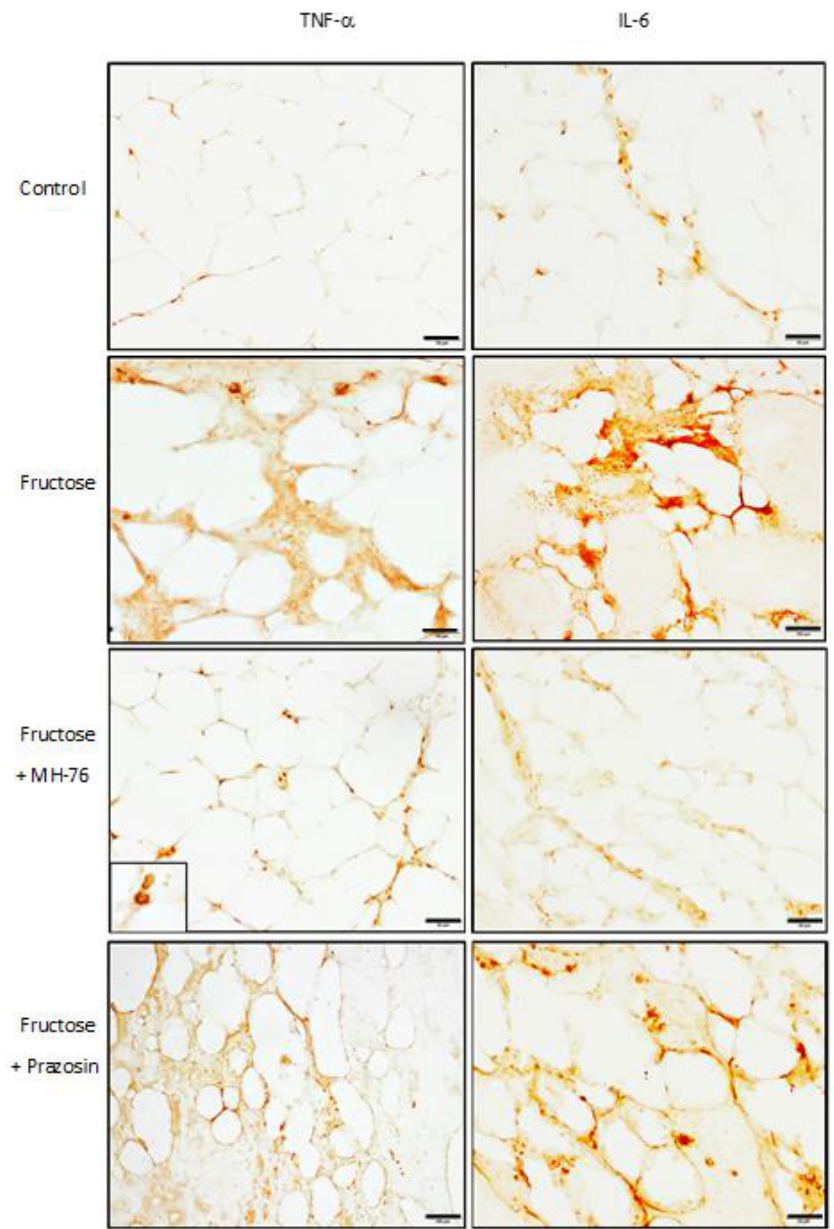
Figure 10. The representative immunohistochemical (IHC) photomicrographs of proinflammatory cytokines—TNF- α and Il-6 expression in the abdominal adipose tissue samples from studied groups. Both IL-6 and TNF- α expression was present in inflammatory cells (in enlarged box), in some endothelial cells and also in adipocytes and were elevated in Fructose and Fructose + Prazosin groups. These observations are similar to that obtained from histopathological analysis (inflammatory index). Bar = 100 μm.